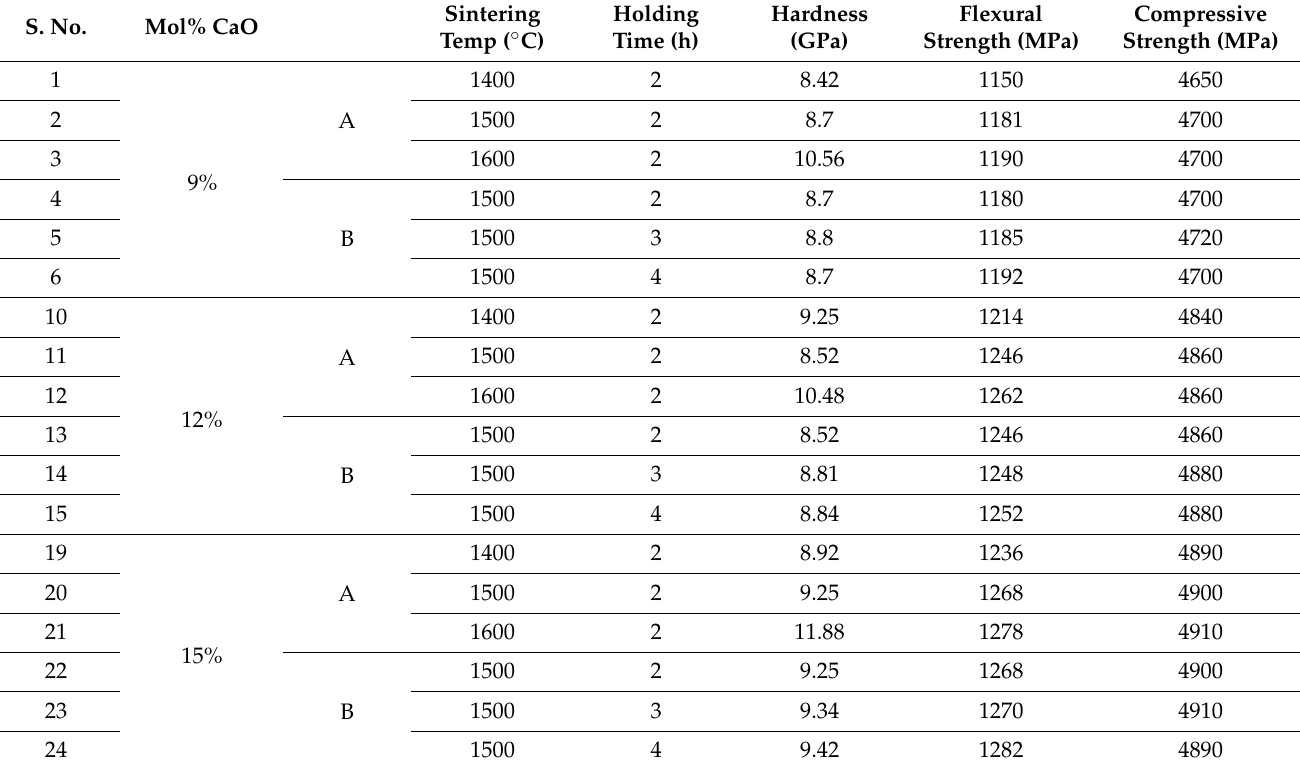
Table 5. Vicker hardness, flexural strength, and compressive strength of CSZ